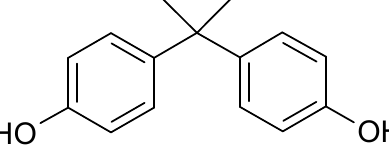
Figure 1. Chemical structure of BPA.